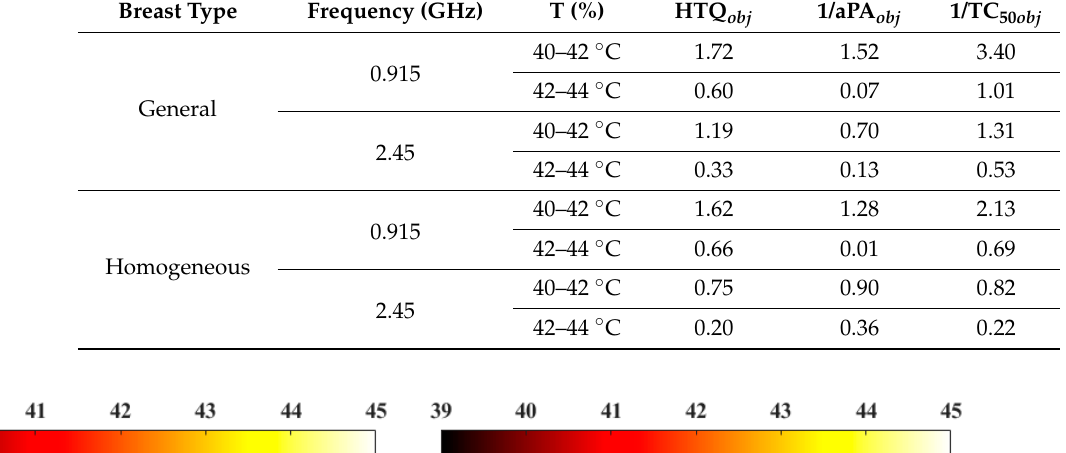
Table 8. Mean and standard deviation of damaged healthy tissue rate for two breast models using DE.